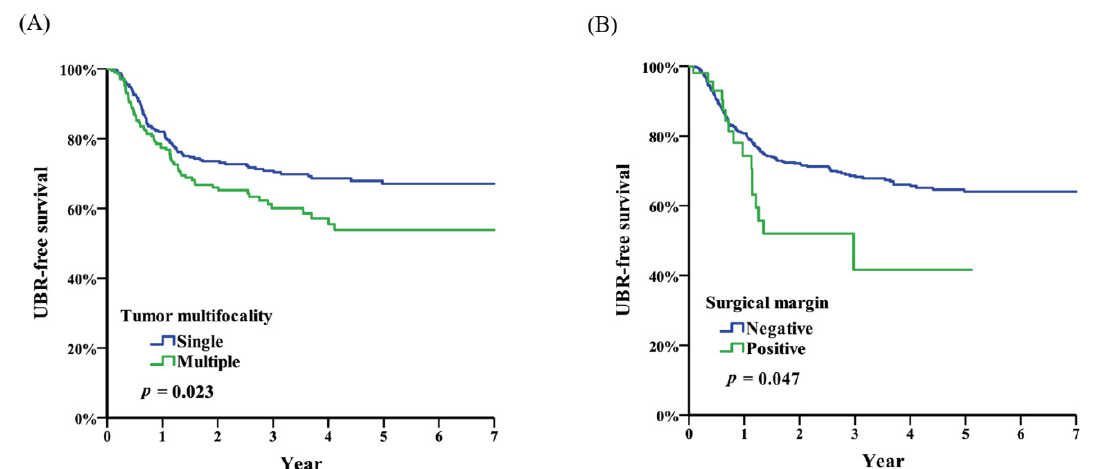
Figure 2. Urinary bladder recurrence (UBR)-free survival stratified by ( A ) surgical margin; and ( B ) tumor